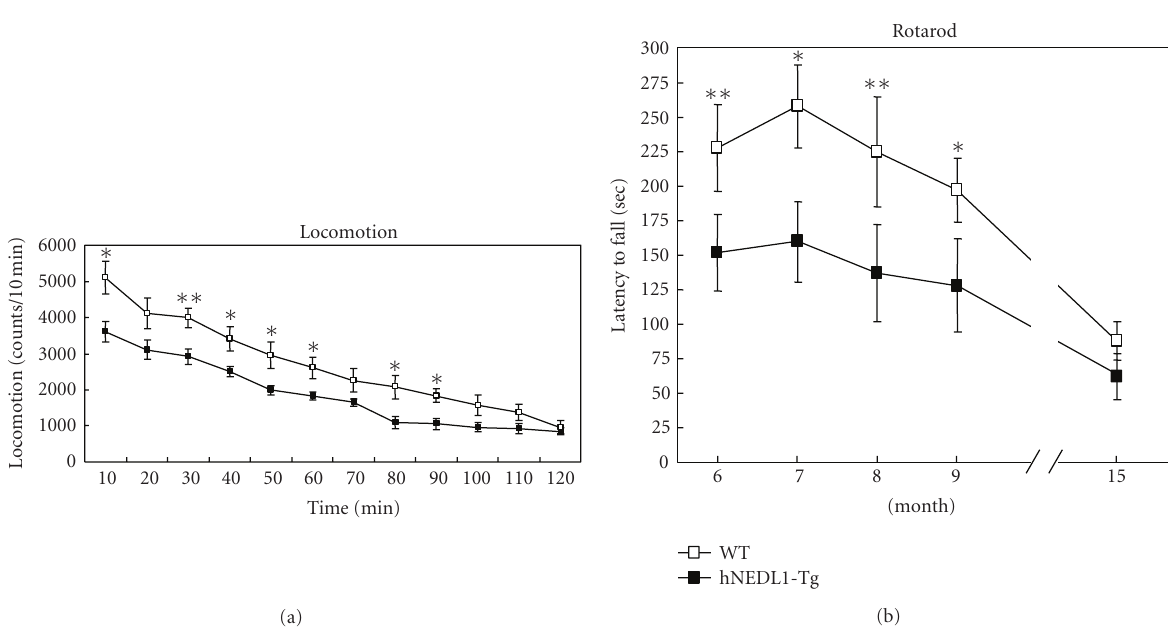
Figure 2: Overexpression of hNEDL1 a ff ected the locomotion and rotarod performance. (a) Behavior (locomotion) in the mice was evaluated; each value (counts per 10min) is the mean ± SEM ( n = 11 ∼ 12; ∗ P < . 05; ∗∗ P < . 01). (b) The rotarod performance of wild-type (white bar: n = 12) and hNEDL1-Tg mice (black bar: n = 11) from the age of six mounths to fifteen months. Data are mean ± SEM ( ∗ P < . 05; ∗∗ P < . 01).